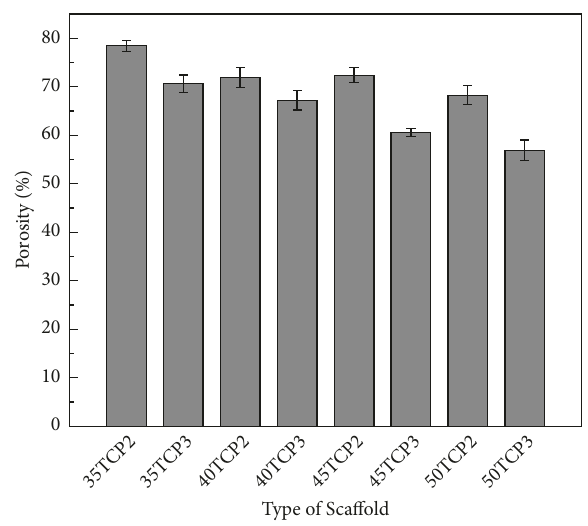
Figure 3: Porosity of 𝛽 -TCP scaffold with TCP content and coating times. Error bar represents mean ± Standard Deviation (SD); 𝑛 = 5